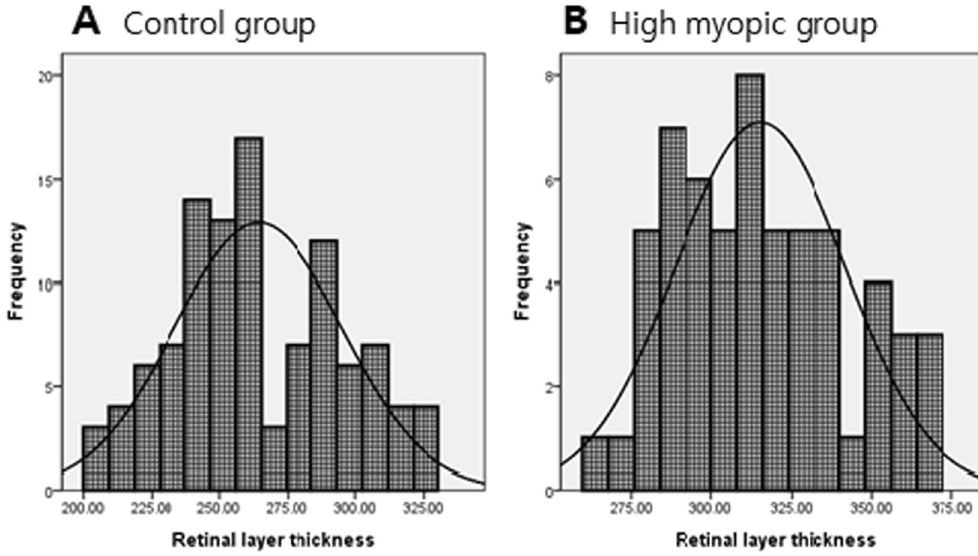
Figure 1. Distribution of total retinal layer thickness ( μ m) in 105 normal volunteers ( A ) and in 59 high myopia volunteers ( B ) compared with normal distribution (solid